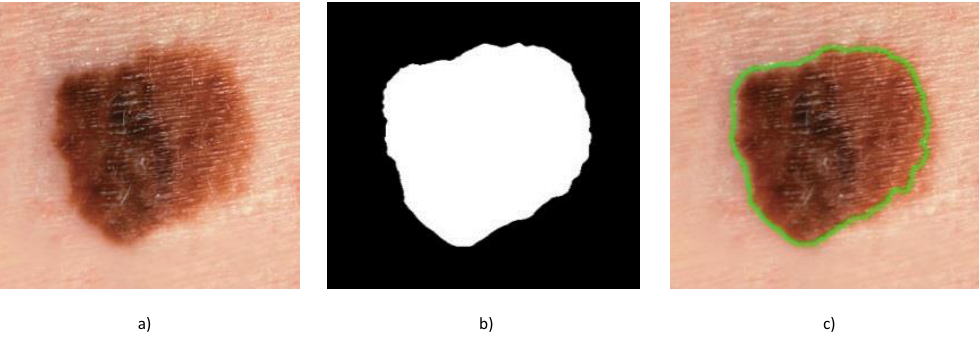
Figure 2. Segmentation of skin lesion: ( a ) original RGB image; ( b ) binary mask; ( c ) traced skin lesion, where the lesion boundary is drawn in green overlaid on the original